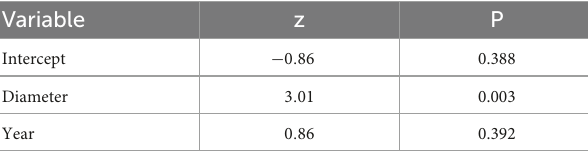
TABLE 2 Overview of the average diameter (cm) of the studied stumps and the average number of entry holes at the study sites during 2015-2017 in the Czechia.